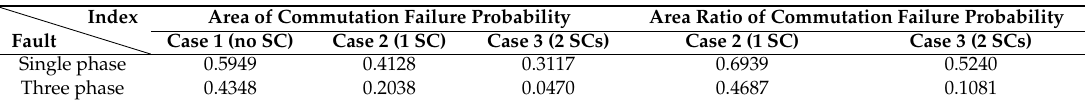
Table 4. Values of area of commutation failure probability and area ratio of commutation failure probability under different types of